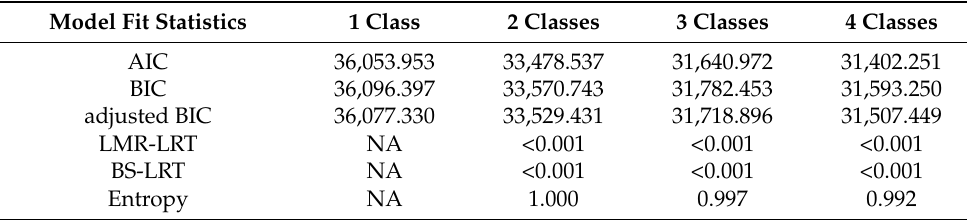
Table 1. Model fit statistics for latent class analysis of time-of-day energy intake patterns 1